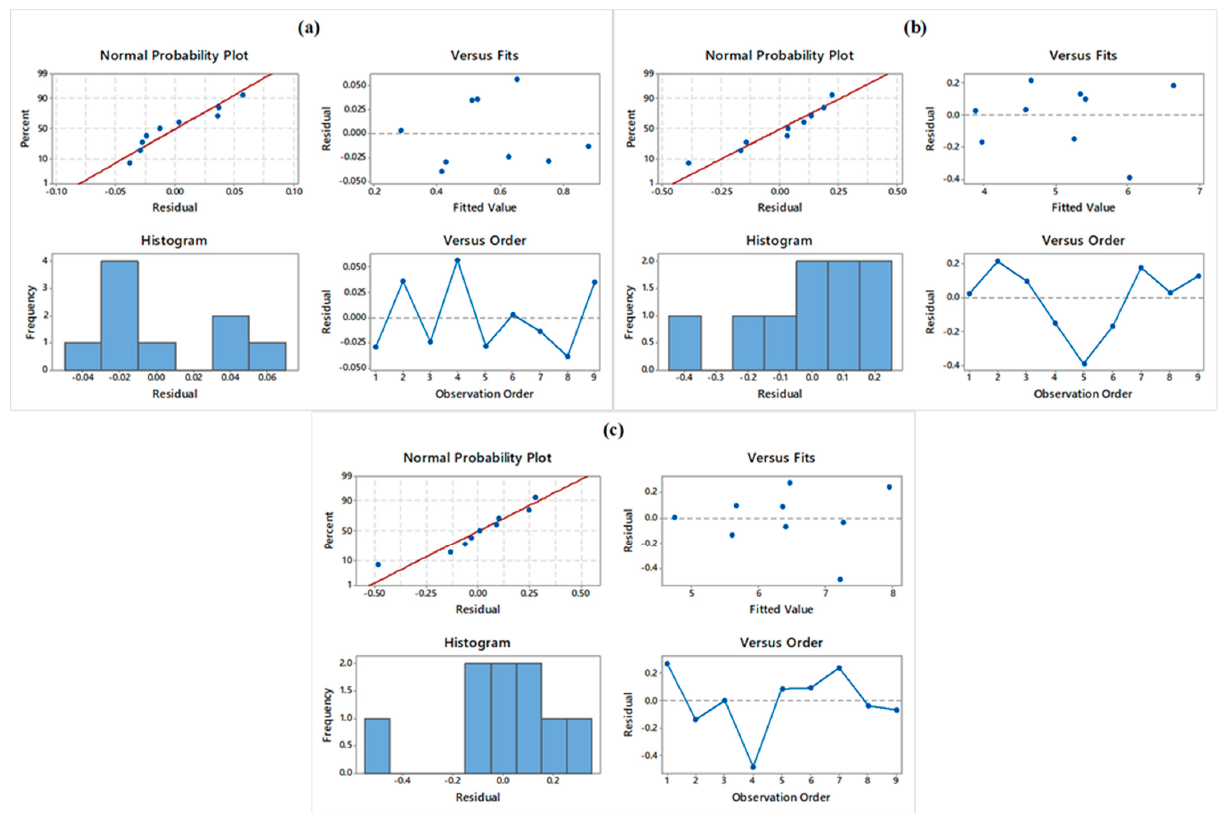
Figure 2. Residual plots for ( a ) MRR, ( b ) SR, ( c ) RLT.